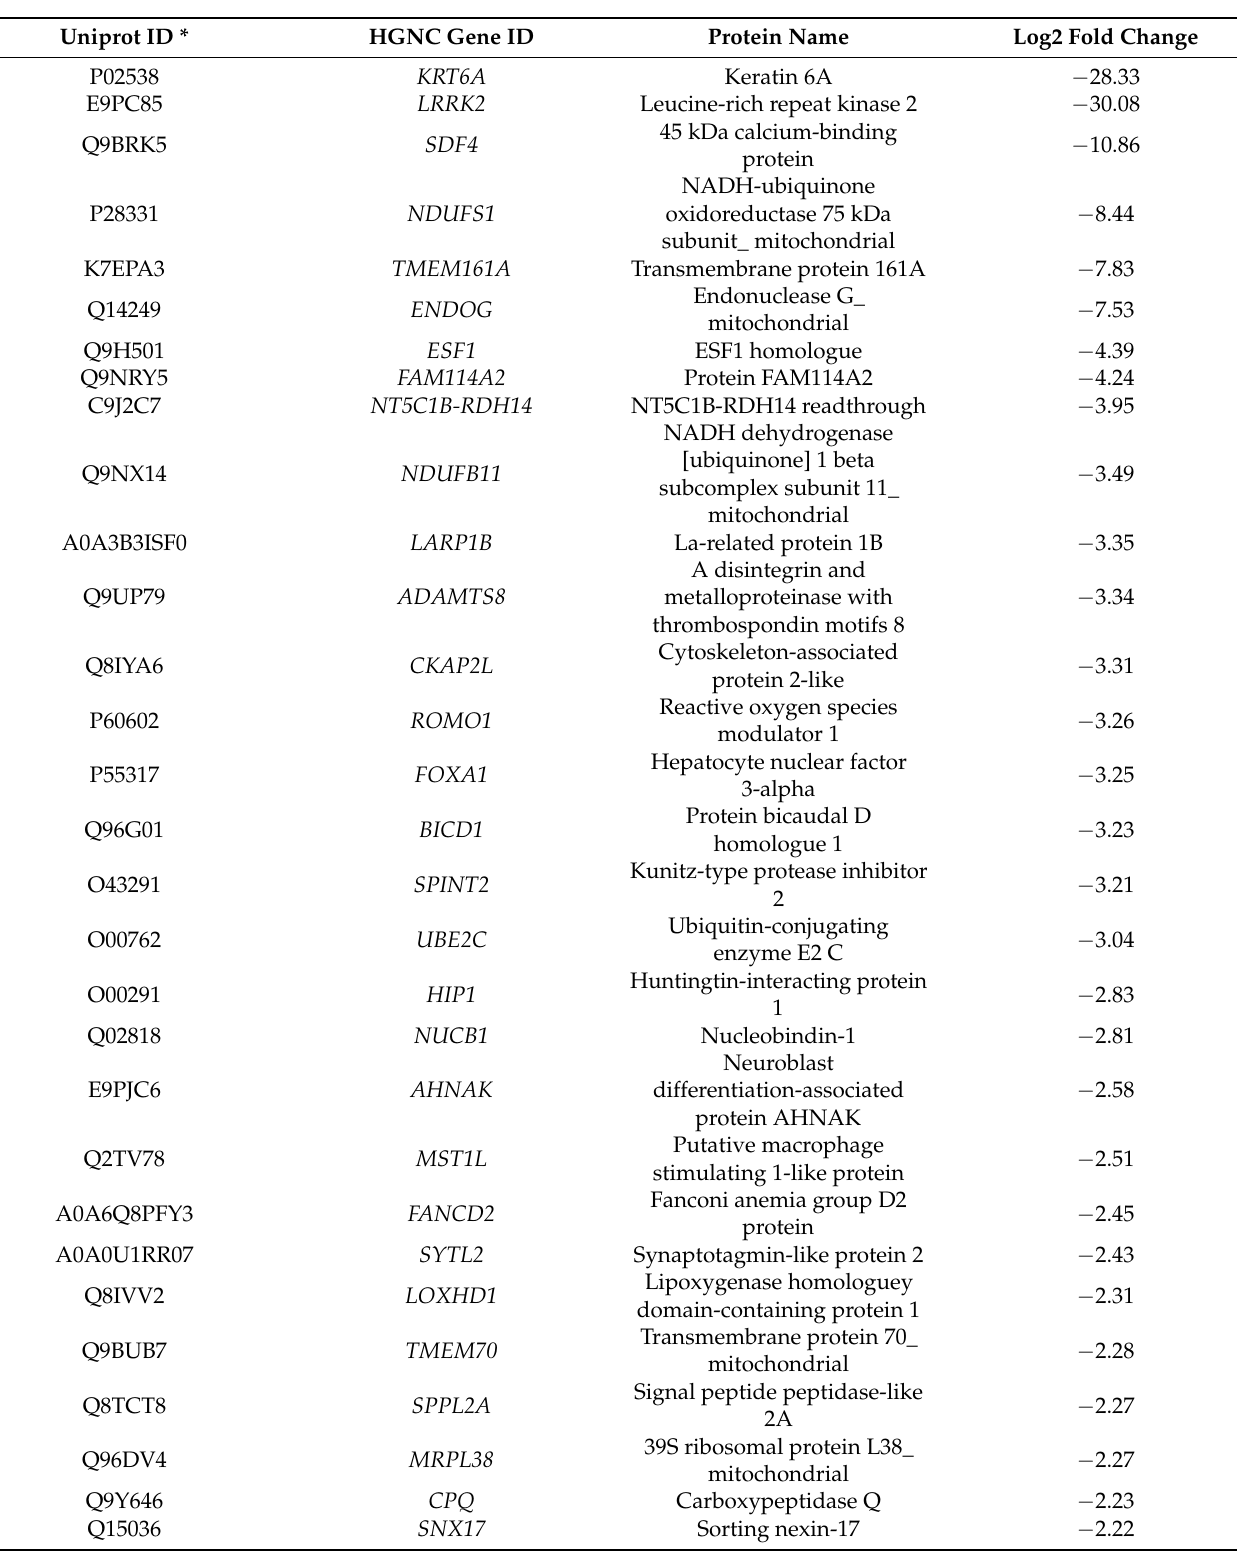
Table 3. Significantly downregulated proteins in cannabidiol-treated MCF7